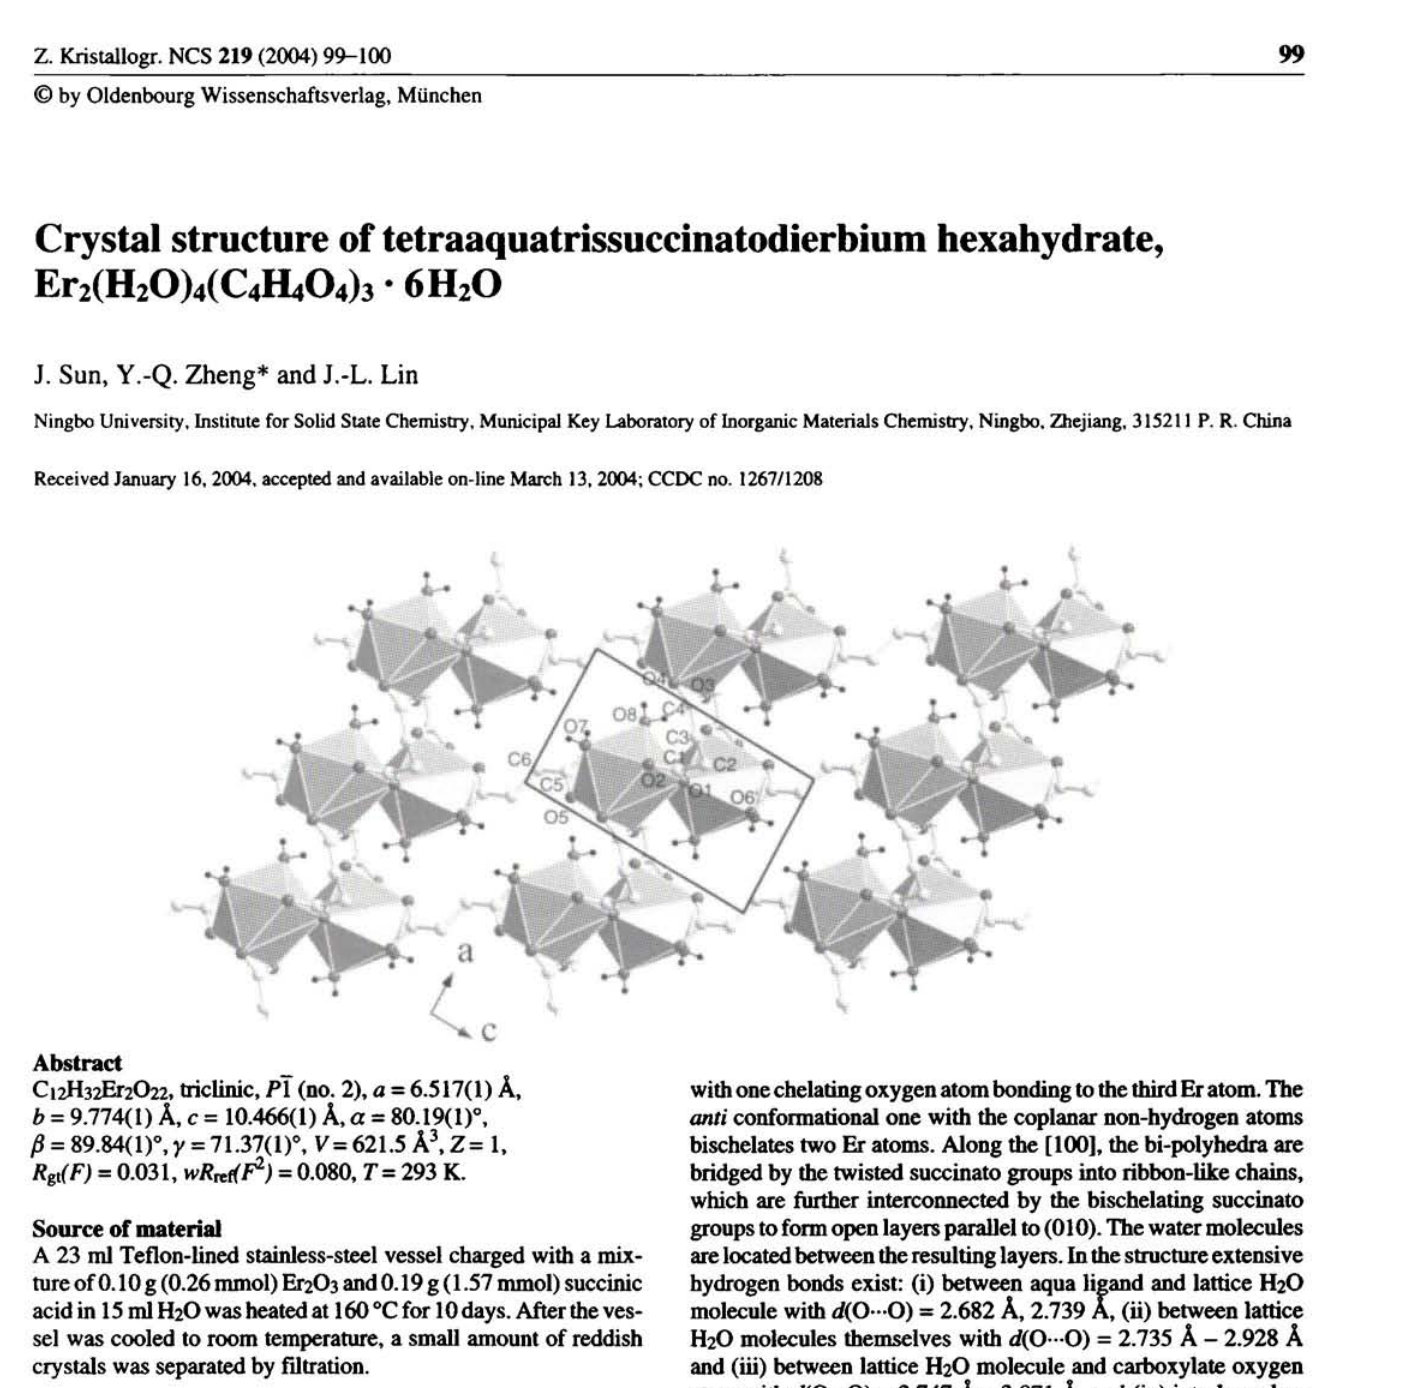
Table 1. Data collection and